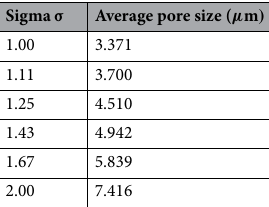
Table 7. Average pore size evaluation for every sigma’s pore size distribution.